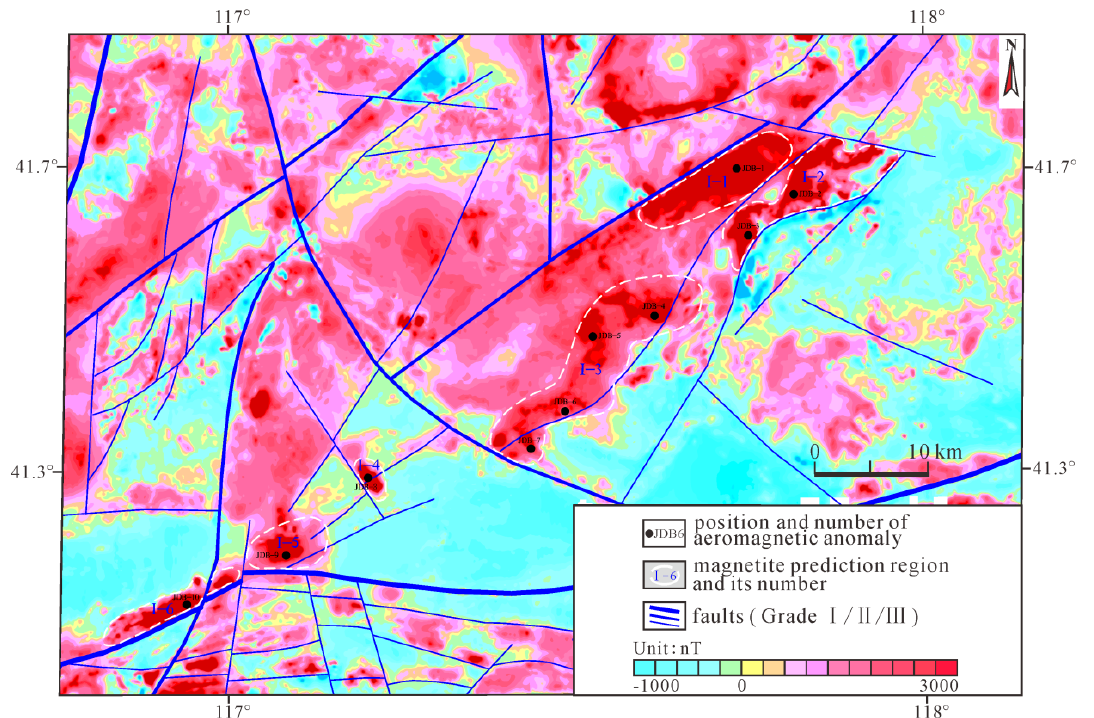
Figure 6. Reduction to the pole of aeromagnetic data ∆ T and magnetite prediction region in northeast Hebei: I-1: Ore prediction region of iron polymetallic in Laochenjia, I-2: Iron ore prediction region of Dabai-Henan, I-3: Iron ore prediction region of Jiuwuying-baiyingzi, I-4: Ore prediction region of iron polymetallic in Beierying, I-5: Ore prediction region of iron polymetallic in Sidaogoumen, I-6: Ore prediction region of iron polymetallic in Wuyingizi.